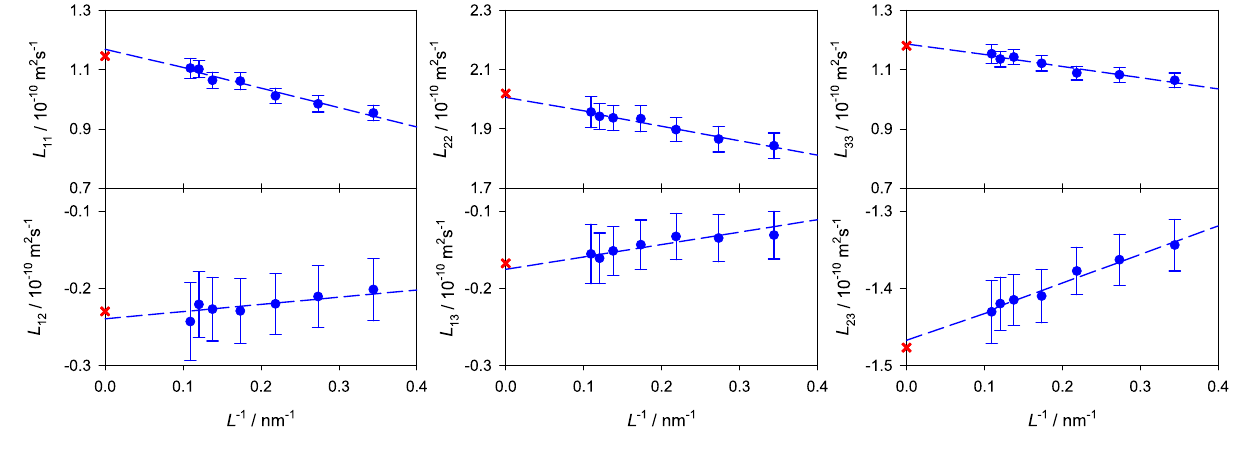
Figure 12. Phenomenological coefficients of the ternary subsystem water (1) + ethanol (2) + 2-propanol (3) 1 ( x H2O = 0.125 , x C2H6O = 0.625 and x C3H8O = 0.25 molmol − ) as a function of the inverse edge length of the simulation volume L at 298.15 K and 0.1 MPa. The uncorrected simulation results (blue bullets) are shown together with the corrected values using the fast correction procedure 12 for N = 6000 (red crosses). The blue dashed line is a linear fit to the uncorrected simulation results.